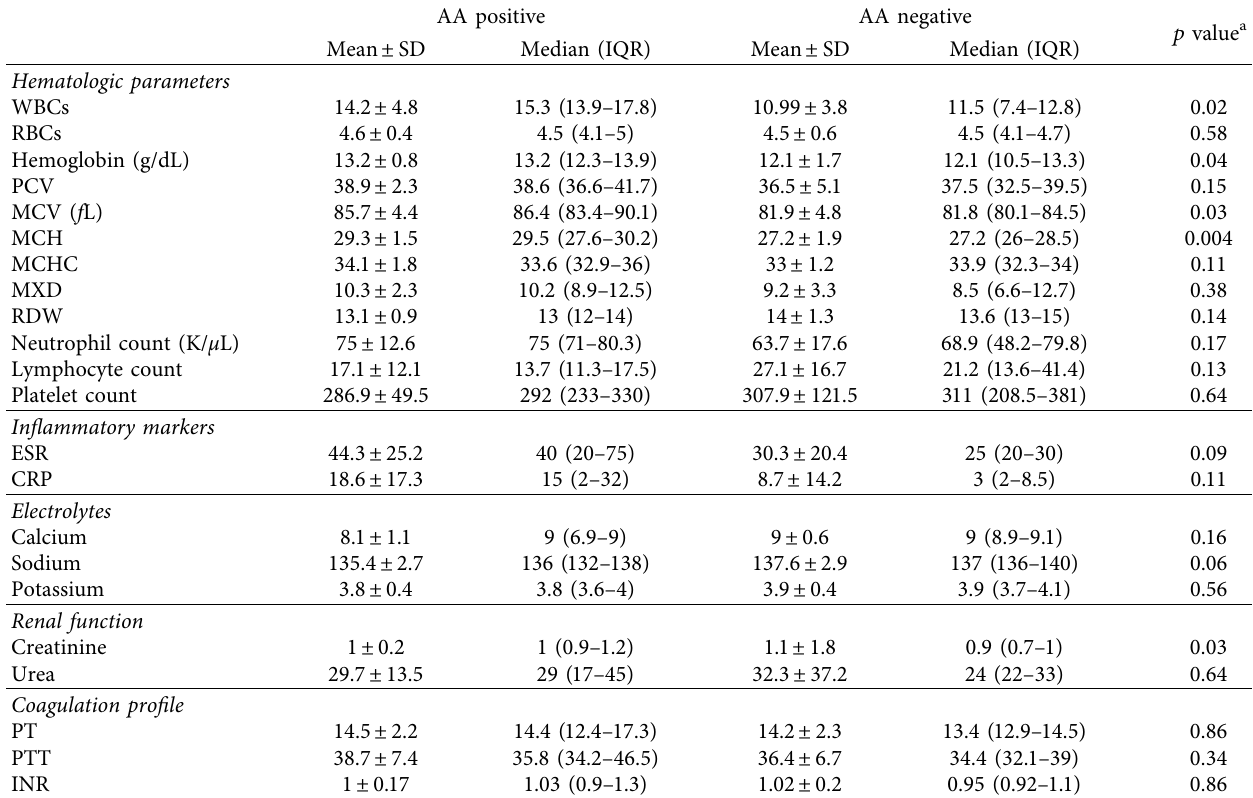
Table 4: Laboratory measurements of study participants stratifed by the presence or absence of